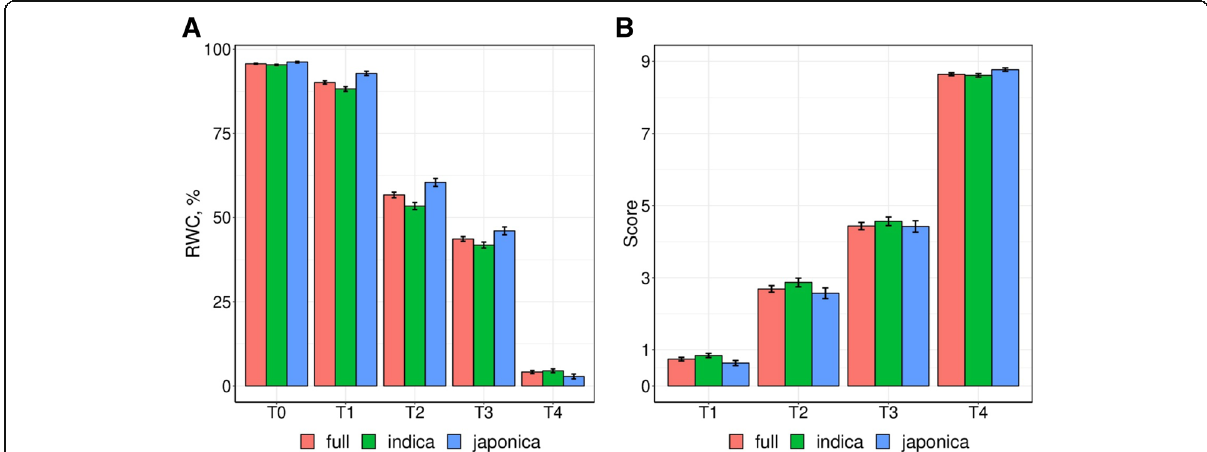
Fig. 1 Variation of relative water content in leaf ( a ) and SES score ( b ) from 0 to 4 weeks of drought stress according to the three panels. RWC, relative water content; Score, drought sensitivity score; T0, the day before drought treatment; T1 to T4, one to four weeks of drought stress